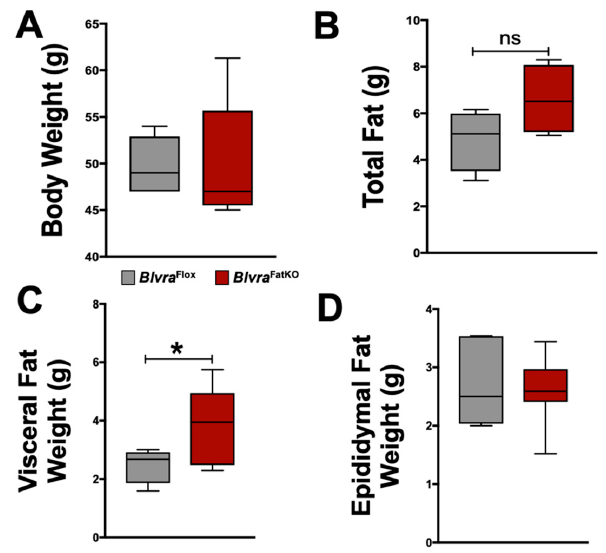
Figure 2. Bodyweight and fat distribution in Blvra Flox and Blvra FatKO mice fed a high-fat diet. ( A ) Body weights at the end of the 12-week HFD; ( B ) Total fat at the end of the 12-week HFD; ( C ) Visceral Fat at the end of the 12-week HFD; ( D ) Epididymal fat at the end of the 12-week HFD. *, p < 0.05 (vs. Blvra Flox ).